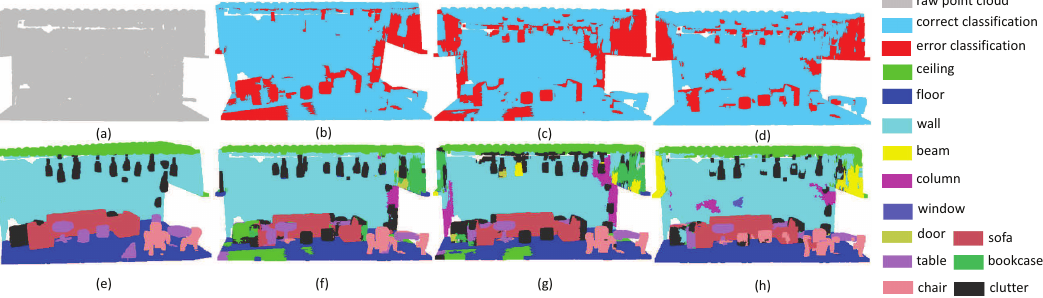
Figure 17. The segmentation results on LoungeS 3 D . ( a ) input, ( e ) ground truth, ( b , f ) the classification result by PointNet++, ( c , g ) the classification result by PointSIFT, and ( d , h ) the classification result by SAN.